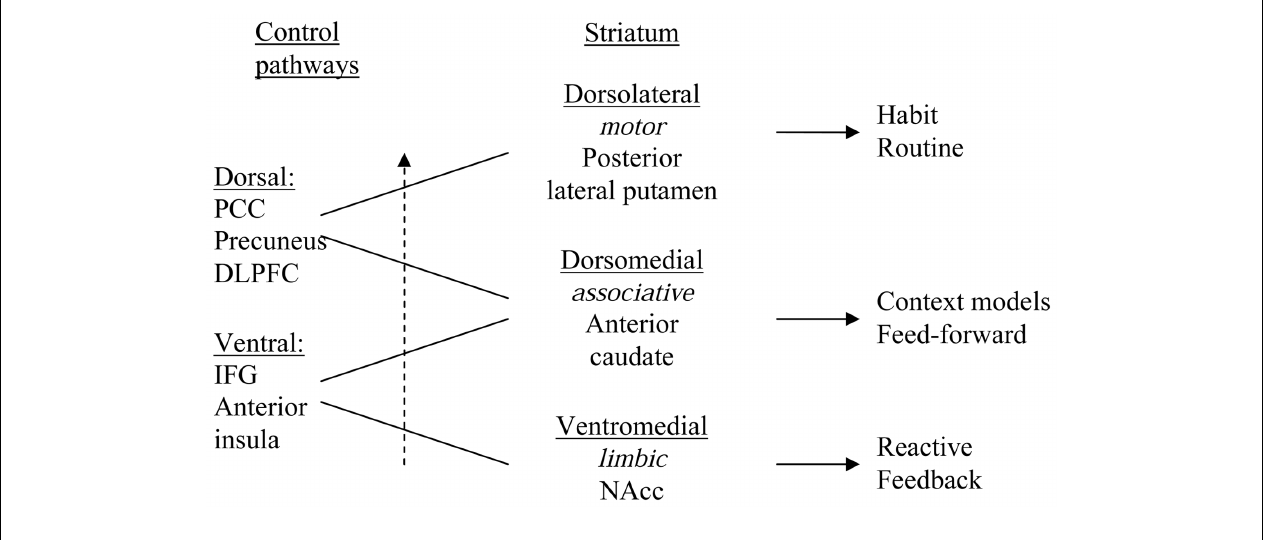
shown), that forms an ascending spiral between regions. The ventromedial striatum influences the dorsomedial striatum and the dorsomedial striatum influences the dorsolateral striatum. IFG, inferior frontal gyrus (ventrolateral prefrontal cortex); PCC, posterior cingulate cortex; DLPFC, dorsolateral prefrontal cortex; NAcc, nucleus accumbens/ventral